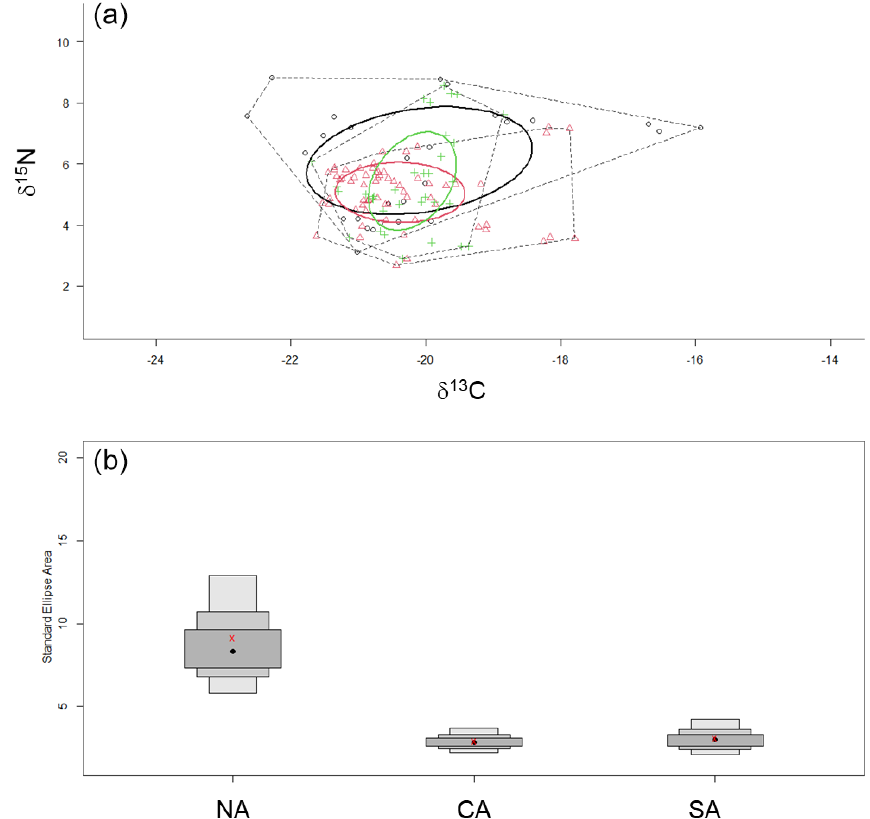
Figure 6. (a) Standard ellipse areas for the three zooplanktonic communities analysed. The black circle and symbols indicate the NA community; the red ones indicate the CA community; and the green ones indicate the SA community. (b) Credible intervals for the estimated SEAc of the three communities. NA: northern Adriatic, CA: central Adriatic, SA: southern